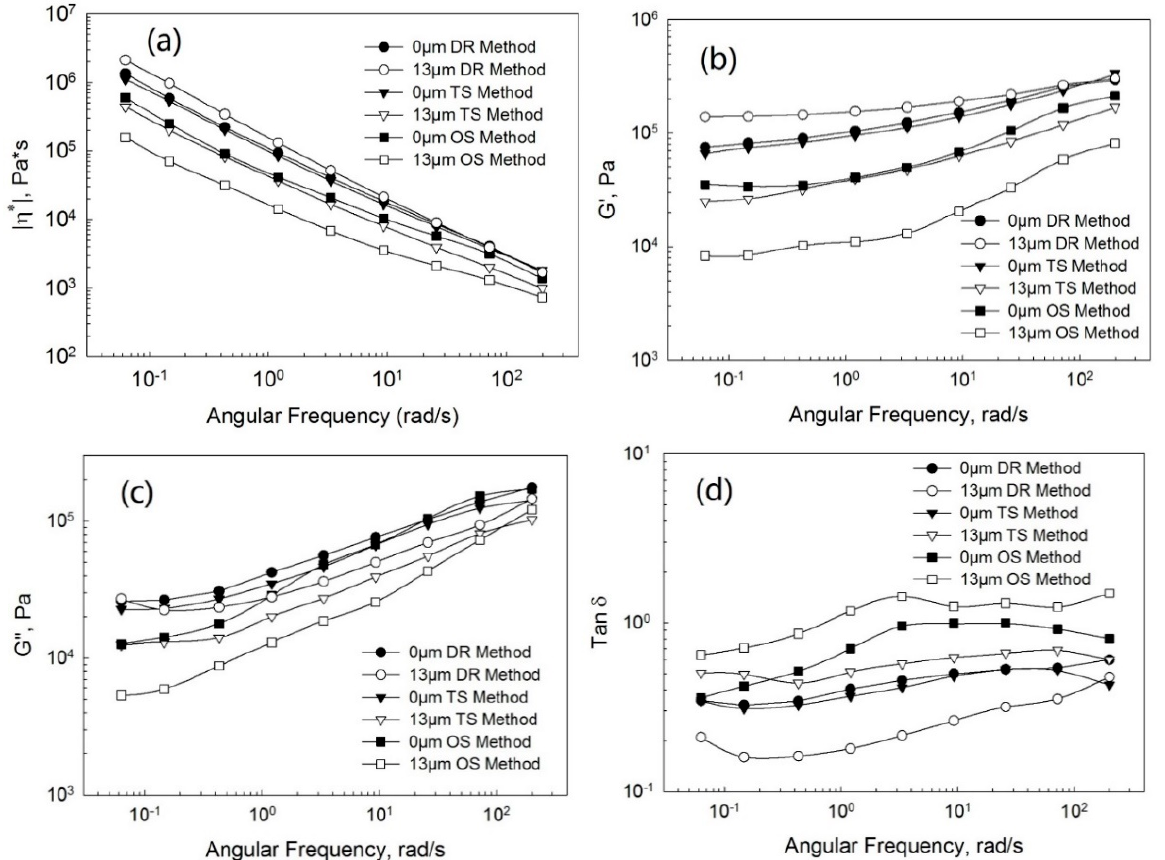
Figure 9. Complex viscosity ( a ), storage moduli ( b ), loss moduli ( c ), and loss tangent ( d ) as a function of the frequency at the ultrasonic amplitudes of 0 µ m (without ultrasonic treatment) and 13 µ m for the PP/EPDM 25/75 blends prepared by the OS, TS, and DR methods.